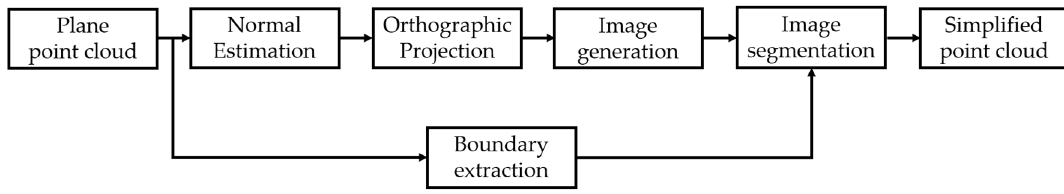
Figure 3. The pipeline of plane simplification.